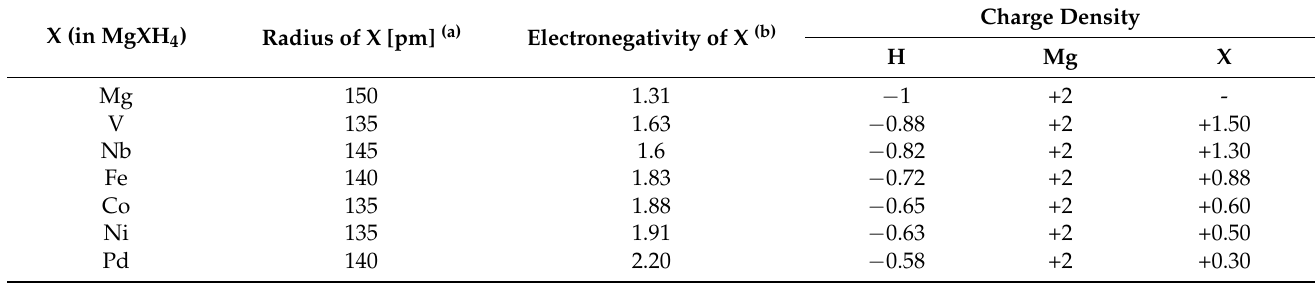
Figure 17. Hydrogen desorption energy ∆ E d (eV per H 2 ) as a function of average electron num- bers around Mg and H atoms of MgH 2 nanowires and the bulk MgH 2 crystal. Reproduced with permission [201]. Copyright 2016, Royal Society of Chemistry. Table 5. Calculated charge density on hydrogen, Mg, and X (X = V, Nb, Fe, Ni, and Pd) together with the electronegativity of additives. Reprinted/adapted with permission from Ref. [128]. Copyright 2016, Royal Society of Chemistry.